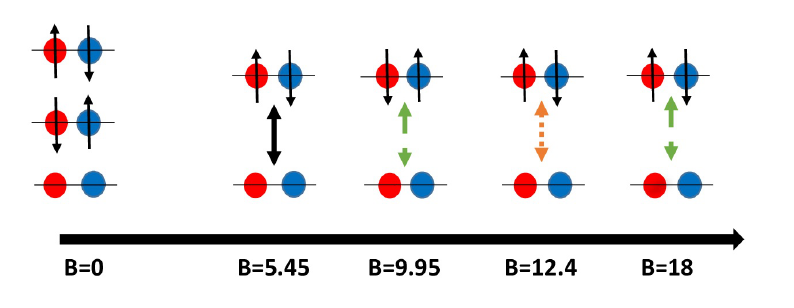
(cid:105) for the 137 Ba + ion and 87 Rb , M F v 2 v 1